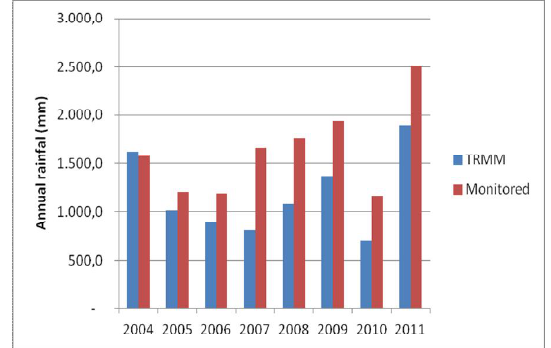
Figure 4. Annual rainfall - TRMM x Monitored data